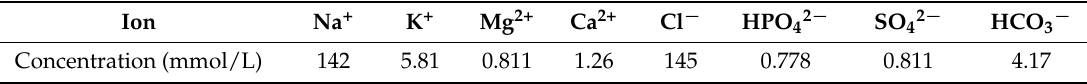
Table 1. Concentrations of electrolytes in Hanks’ Balanced Salt Solution